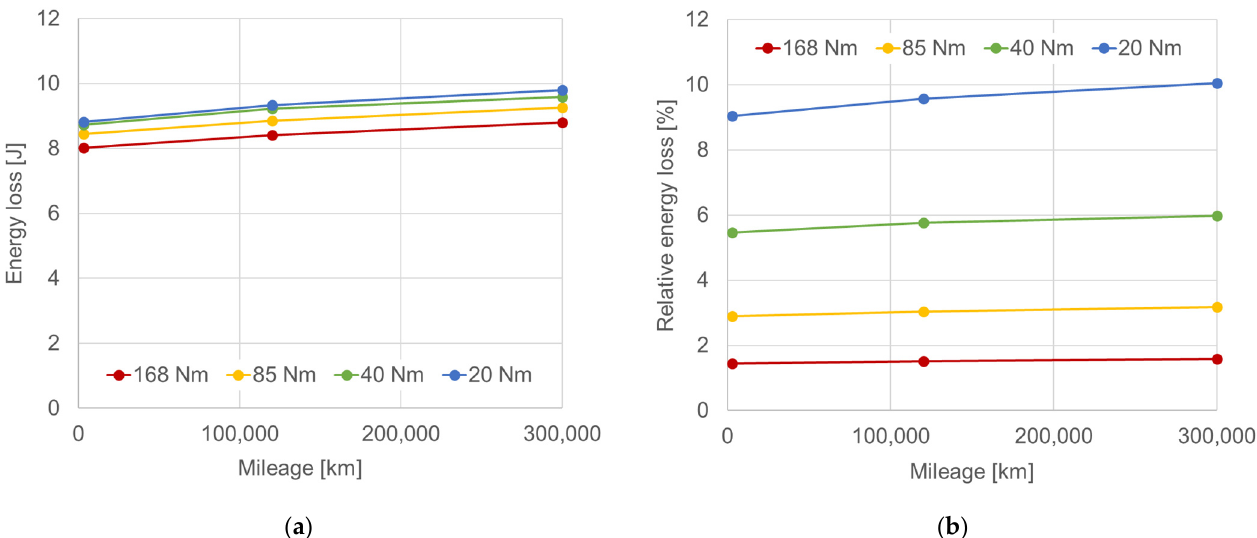
Figure 13. The energy lost by cycle due to ring pack friction at different engine loads and wear: ( a ) absolute values; ( b ) values related to indicated work.